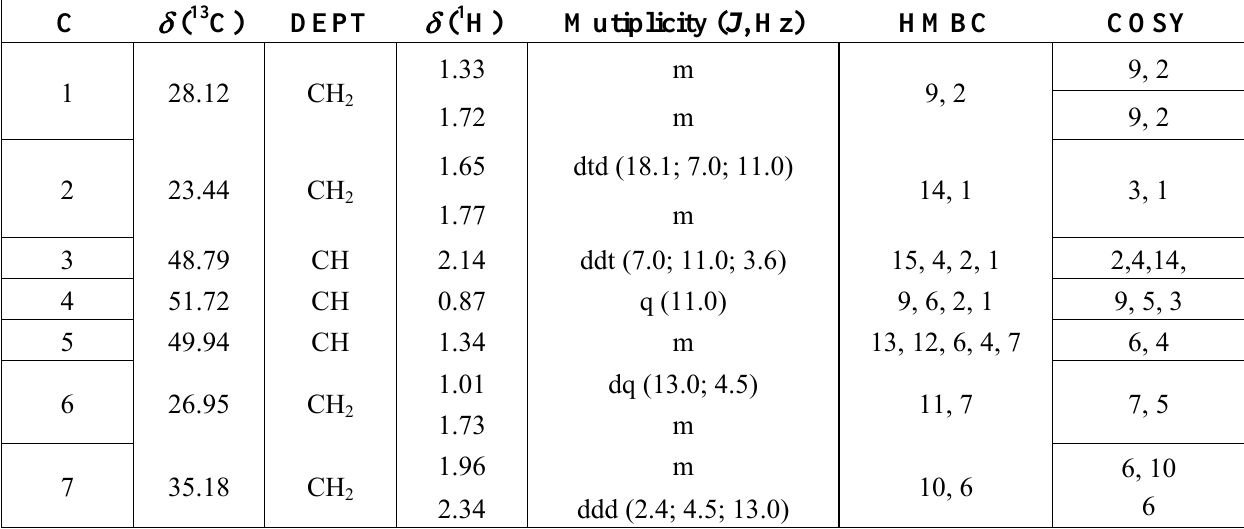
Table 2. 1 H- and 13 C-NMR spectra data, HSQC and HMBC correlations for (14 S )- β -oplopenol ( 2